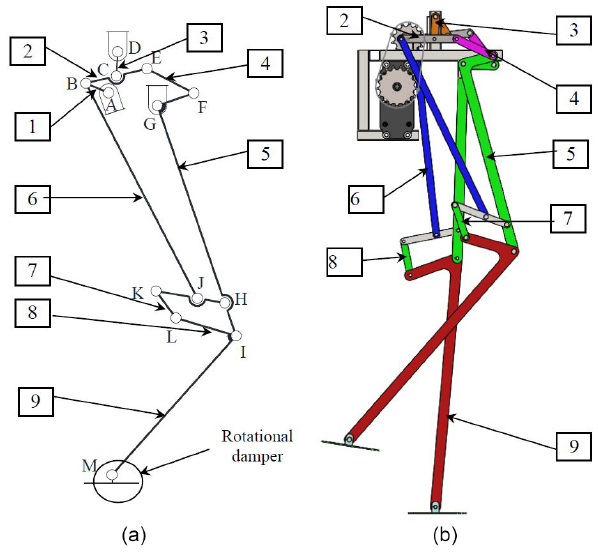
Figure 7. Leg exoskeleton: (a) a kinematic scheme; (b) virtual sim- ulation model of leg